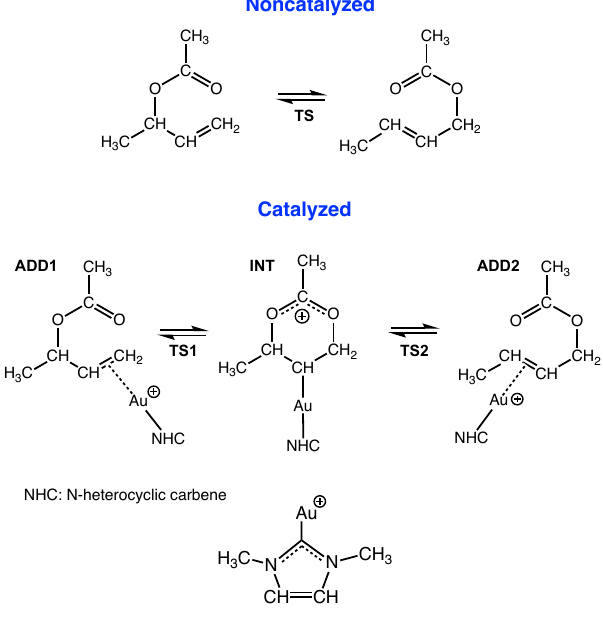
Figure 5. Non-catalyzed and Au(I) catalyzed [3,3]-sigmatropic rearrangement of allyl